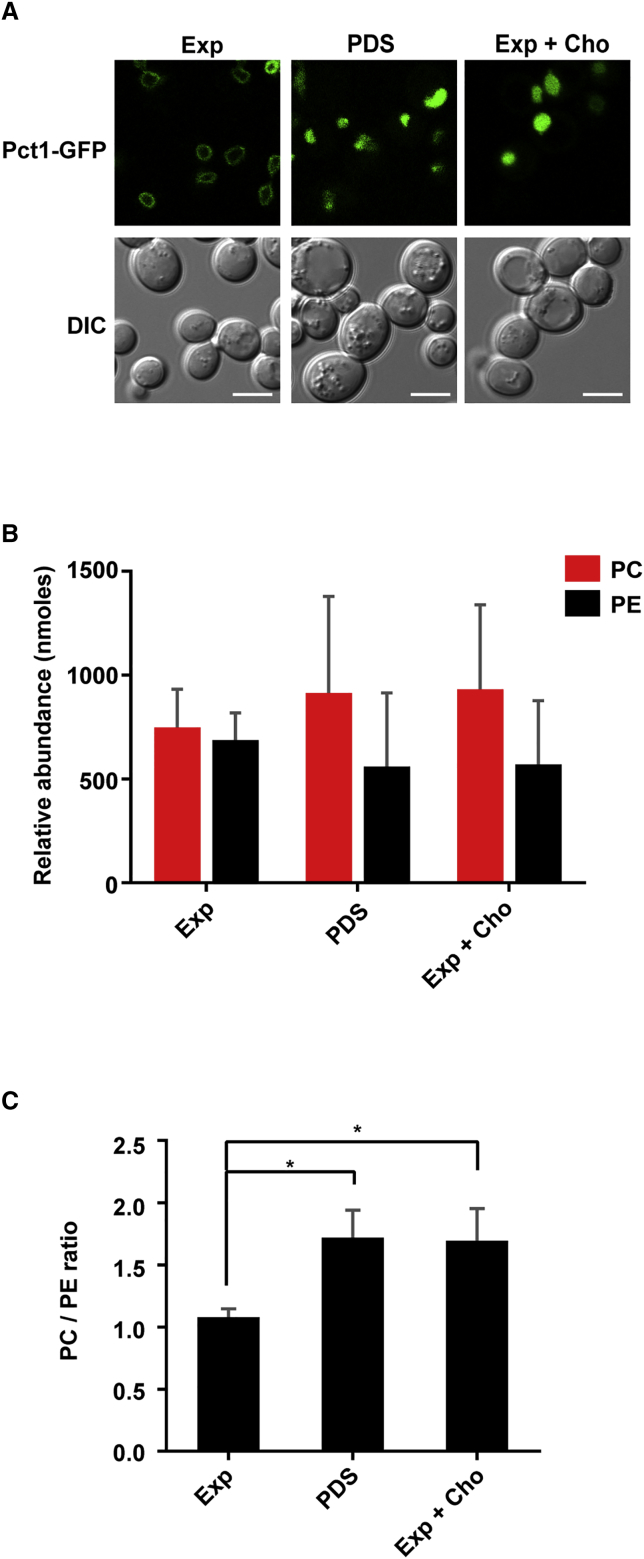
Binding of Pct1-GFP to the Nuclear Membrane Is Associated with PC Levels in Yeast(A) pct1Δ cells expressing C-terminal GFP-tagged Pct1 were grown to exponential phase (Exp), post-diauxic shift (PDS) phase, or to exponential phase supplemented with 1 mM choline (Exp + Cho), and imaged as described in the STAR Methods. Differential interference contrast (DIC) images are shown for context. Scale bars, 5 μm.(B) Lipidomic analysis of PC and PE levels at the indicated growth phase. The PE and PC levels shown in nmol (per 50 mg yeast) are relative to internal standards.(C) PC/PE ratio of WT cells at the indicated growth phase.Data are means ± SD from three independent experiments. One-way ANOVA with Bonferroni multiple comparison ∗p < 0.05. See Figures S3 and S4.